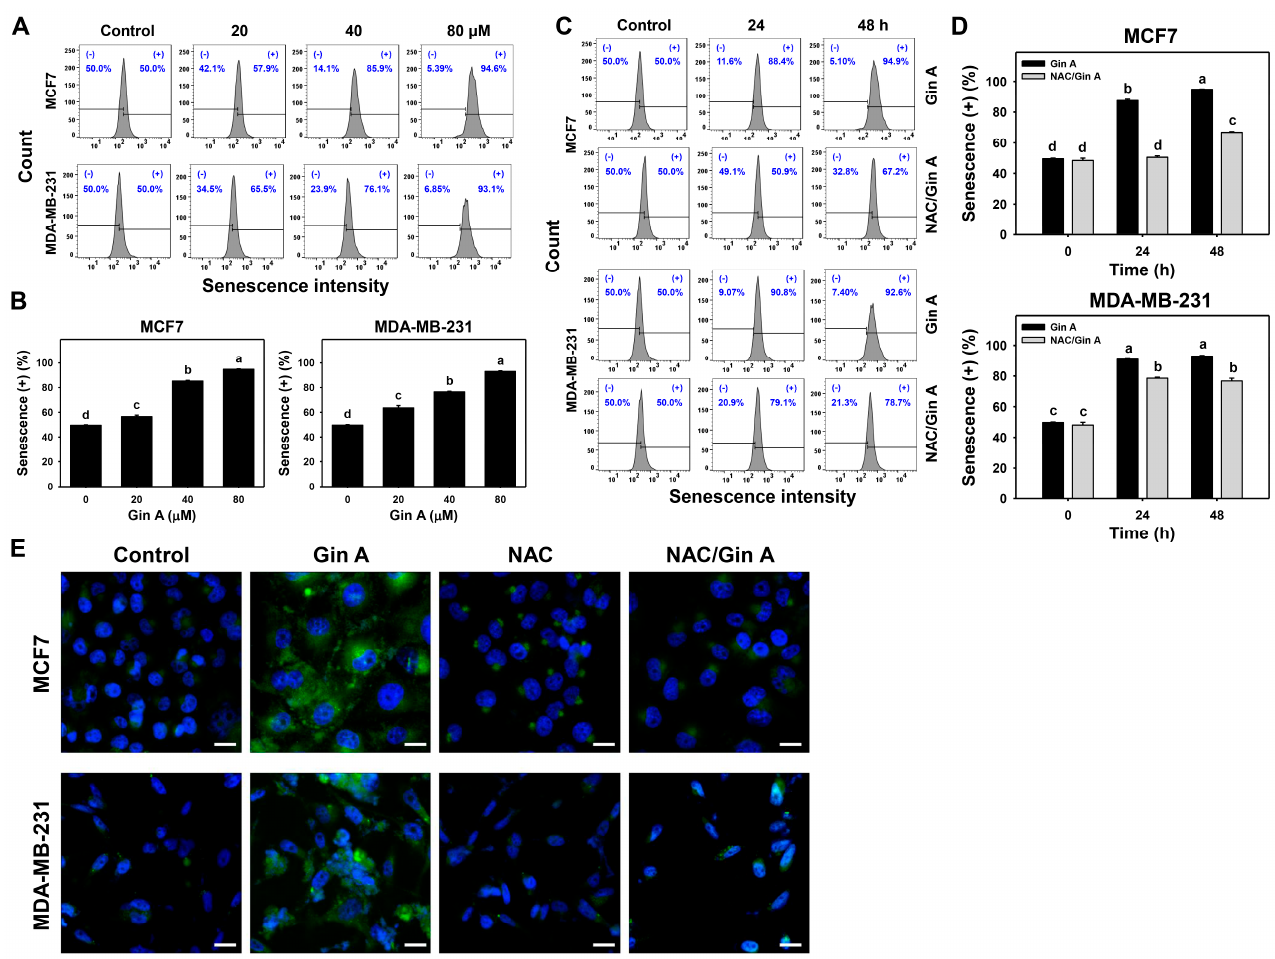
Figure 5. Impact of Gin A on senescence level and phenotype in breast cancer cells. ( A , B ) Senescence β -galactosidase level. Cells were treated with 0 (0.1% DMSO; control), 20, 40, and 80 µ M Gin A for 48 h. Subsequently, they were subjected to senescence flow cytometry. (+) indicates senescence (+) populations. ( C , D ) NAC reverted effects on senescence level. Cells were pretreated with NAC (10 mM) for 1 h and then post-treated with Gin A (control and 80 µ M) for 0, 24, and 48 h, namely NAC/Gin A. Data, means ± SDs ( n = 3). When the connecting letters are overlapping, it means their difference was significant for multiple comparisons ( p < 0.0001). For the example of MCF7 cells ( D ), Gin A at 0, 24, and 48 h showing d , b , and a differs significantly. NAC/Gin A at 24 and 48 h showing d and c differs significantly, whereas Gin A and NAC/Gin A at 0 h showing the overlapping letter d differ non-significantly. ( E ) Fluorescence analysis for β -galactosidase-detected senescence. Cells were stained by the senescence-detecting probe and counterstained with Hoechst 33342. Slides were photographed at 400 × magnification. Scale bar = 20 µ